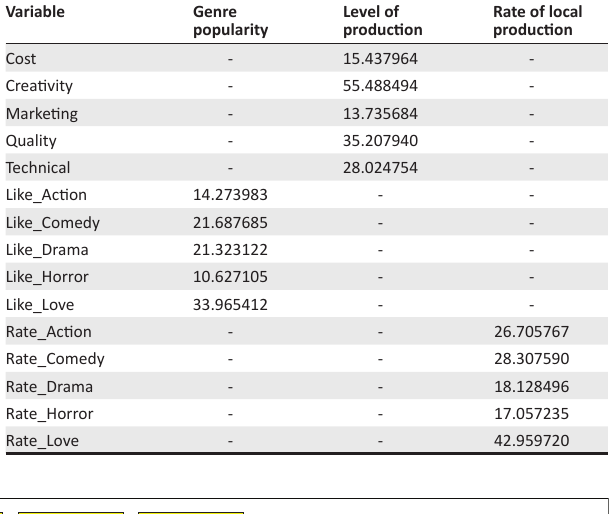
TABLE 1: Outer model loadings.